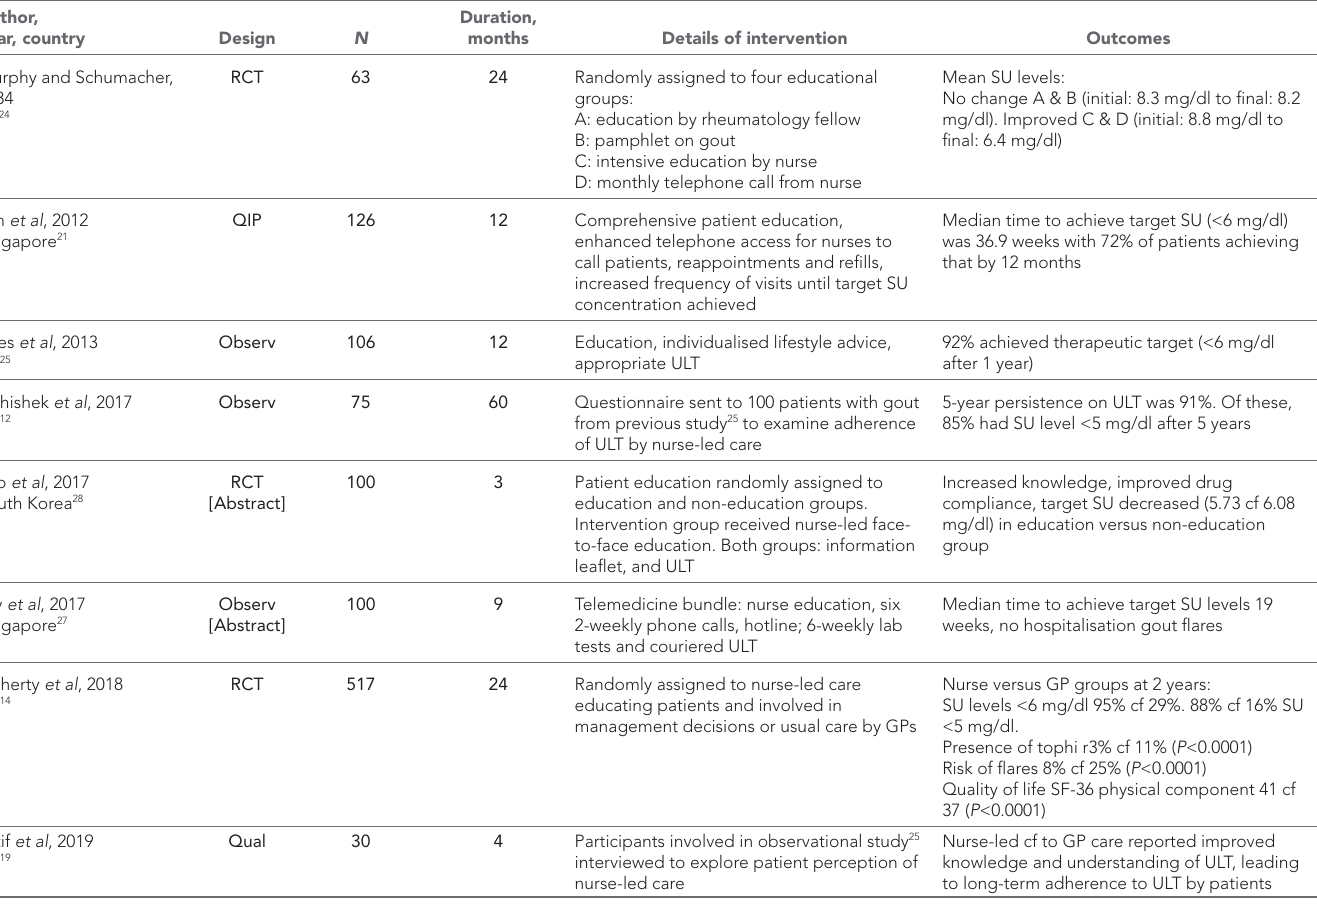
Table 1 Characteristics of included nurse- led studies Author, year,